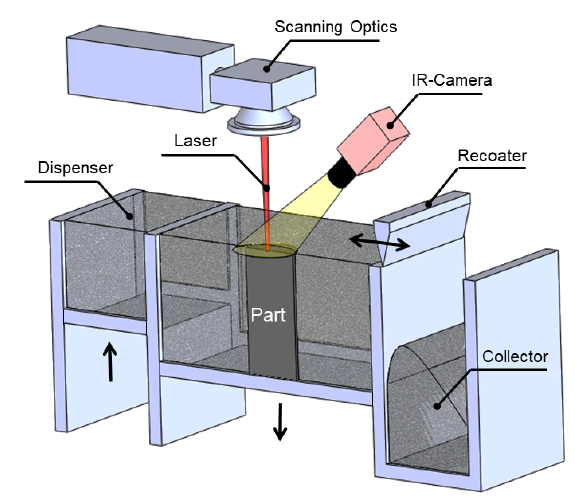
Figure 6. Selective laser melting